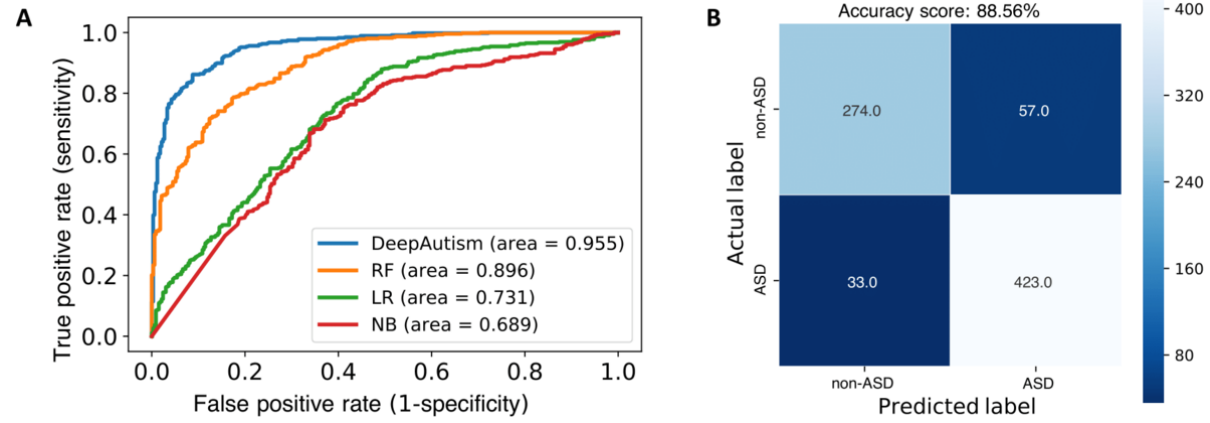
Figure 3. A. The area under the receiver operating characteristic curve of DeepAutism, random forest, logistic regression, and Naive Bayes for predicting autism spectrum disorder diagnosis based on the selected top 100 significantly common variants on the test data. B. The visualization table that describes the performance of the DeepAutism classifier on the test data. DeepAutism correctly predicted 697 out of 787 total samples and correctly predicted autism spectrum disorder in 423 samples out of 456 samples with autism spectrum disorders. AUC: area under the receiver operating characteristic curve; ASD: autism spectrum disorder; NB: Naive Bayes; LR: logistic regression; RF: random forest.